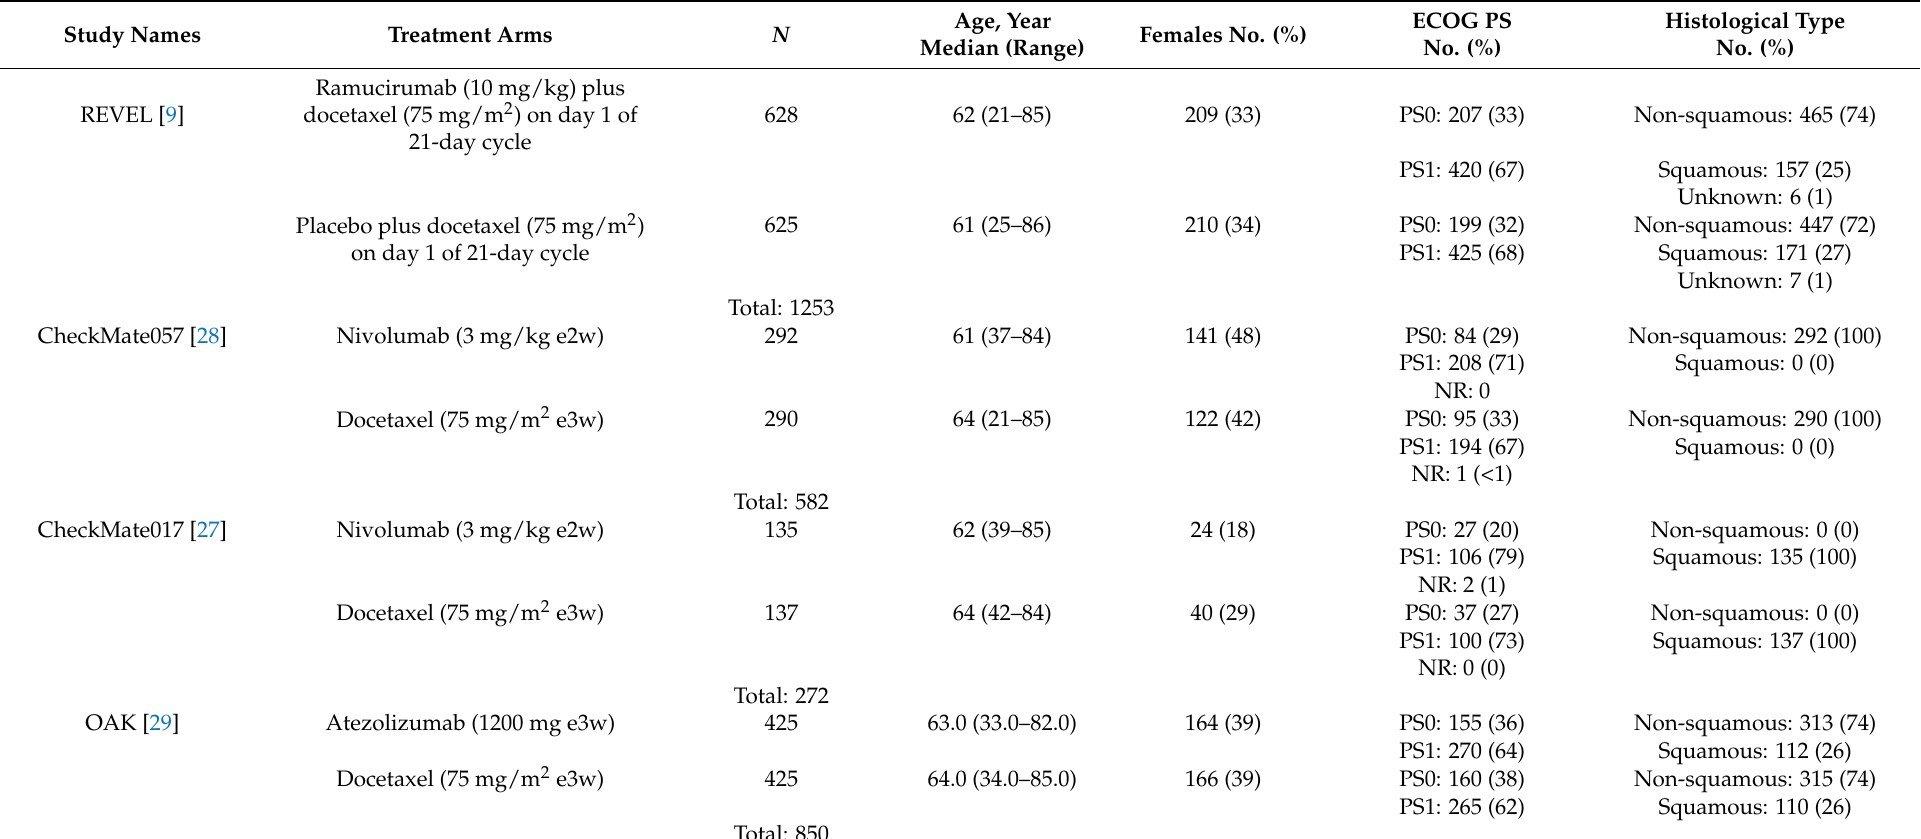
Table 2. Characteristics of the included